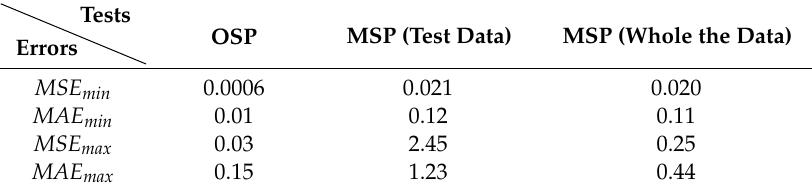
Table 1. Estimation’s maximum and minimum mean squared error (MSE) and mean absolute error (MAE) with four delayed samples considered for each involved parameter (i.e., n = 4). OSP, one-step prediction; MSP, multi-step prediction.